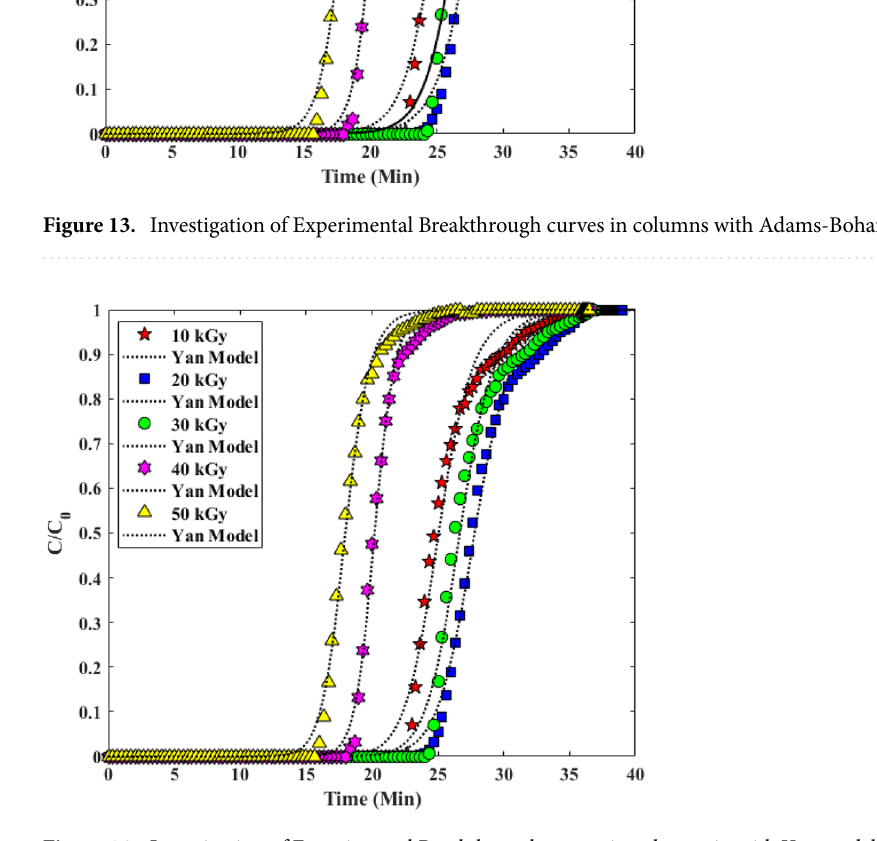
Figure 14. Investigation of Experimental Breakthrough curves in columns in with Yan